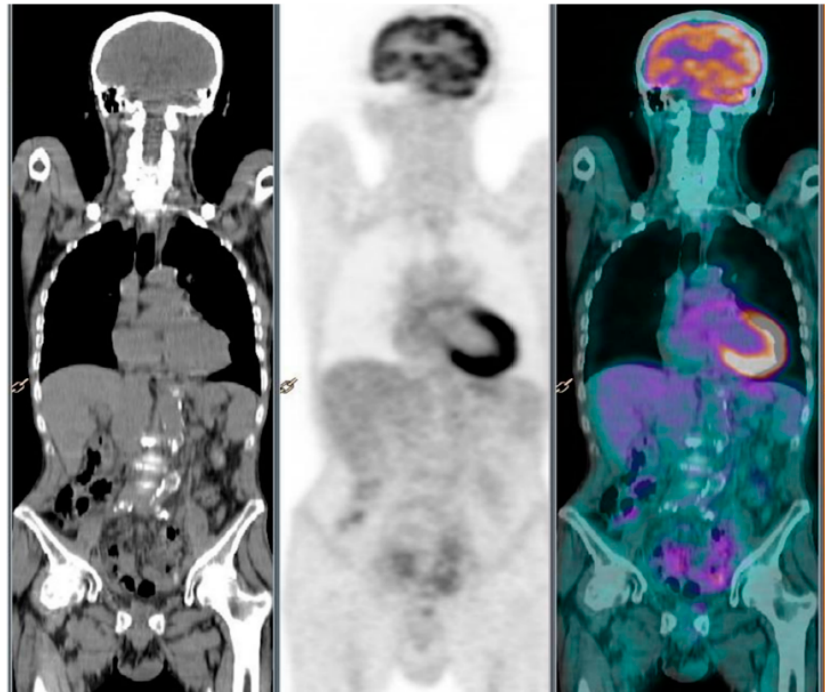
Figure 2. The PET/CT scans performed in December 2017 do not show pathologic masses with high glucose